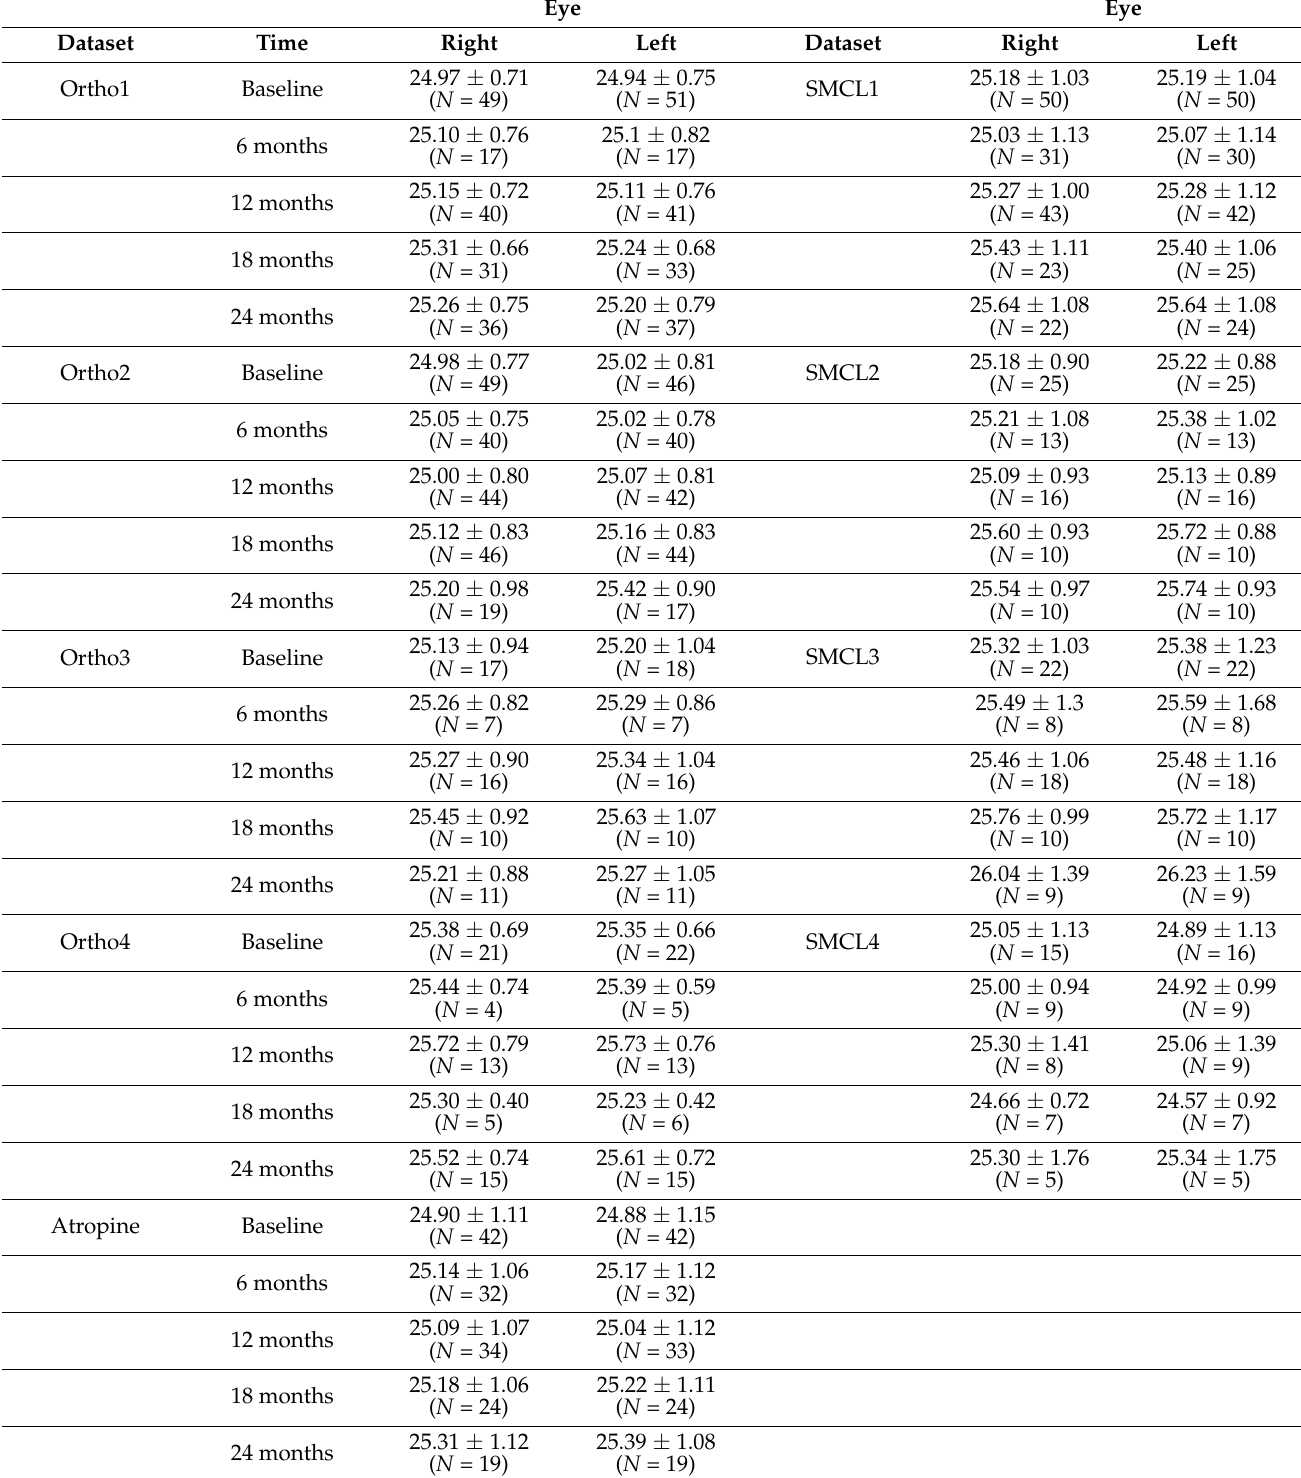
Table 6. Summary statistics for axial length